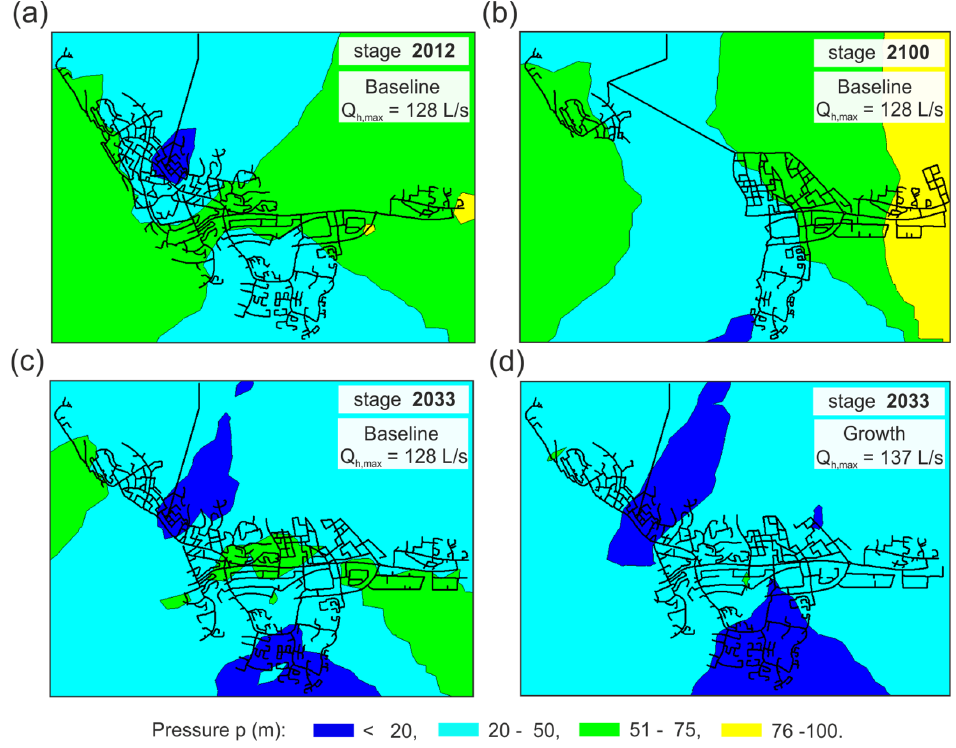
Figure 9. Pressure distributions at peak demand for the Baseline scenario for the initial stage 2012 ( a ), the final stage 2100 ( b ), the transition stage 2033 ( c ), and the Growth scenario for transition stage 2033 ( d ).